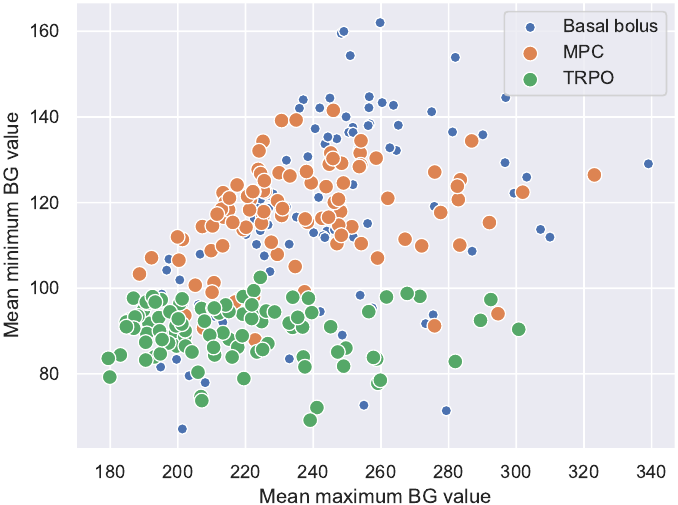
Figure 7. Scatterplot showing the mean of the maximum and minimum values over the 100 meal scenarios for each virtual patient on the x and y axes, respectively. MPC, basal-bolus treatment, and TRPO control is included in the plot. Tight glycemic control is in the mid to lower left area of the plot (a low maximum value and minimum value above 72 is